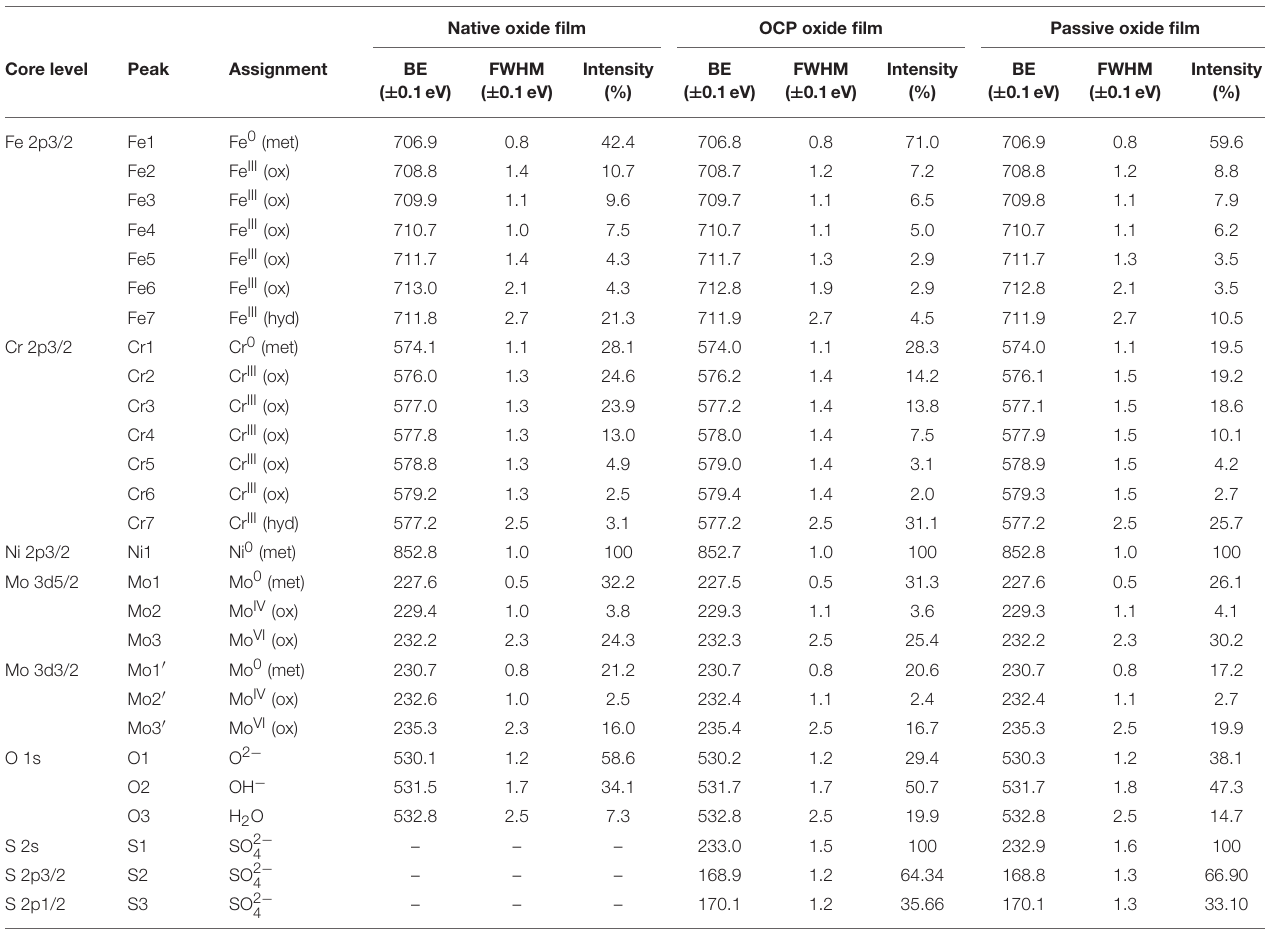
TABLE 1 | BE, FWHM, and relative intensity values of the components measured by XPS on polycrystalline 316L SS after formation in ambient air of the native oxide film, after immersion for 30min at OCP in 0.05M H 2 SO 4 , and after passivation for 30min at 0.5 V/SCE in 0.05M H 2 SO 4 . Native oxide